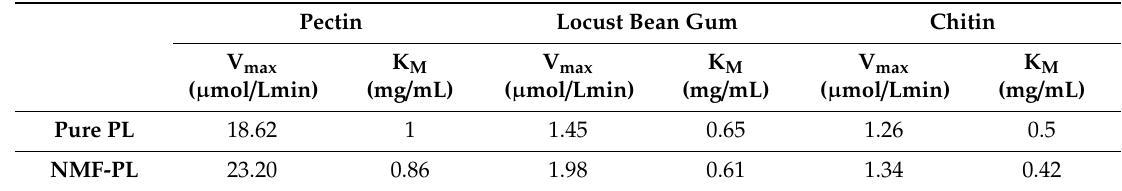
Table 2. Vmax and KM values of pure PL and (Nano Magnetit Flower- Pectin lyase) NMF-PL enzymes for the substrates of pectin, locust bean gum, and